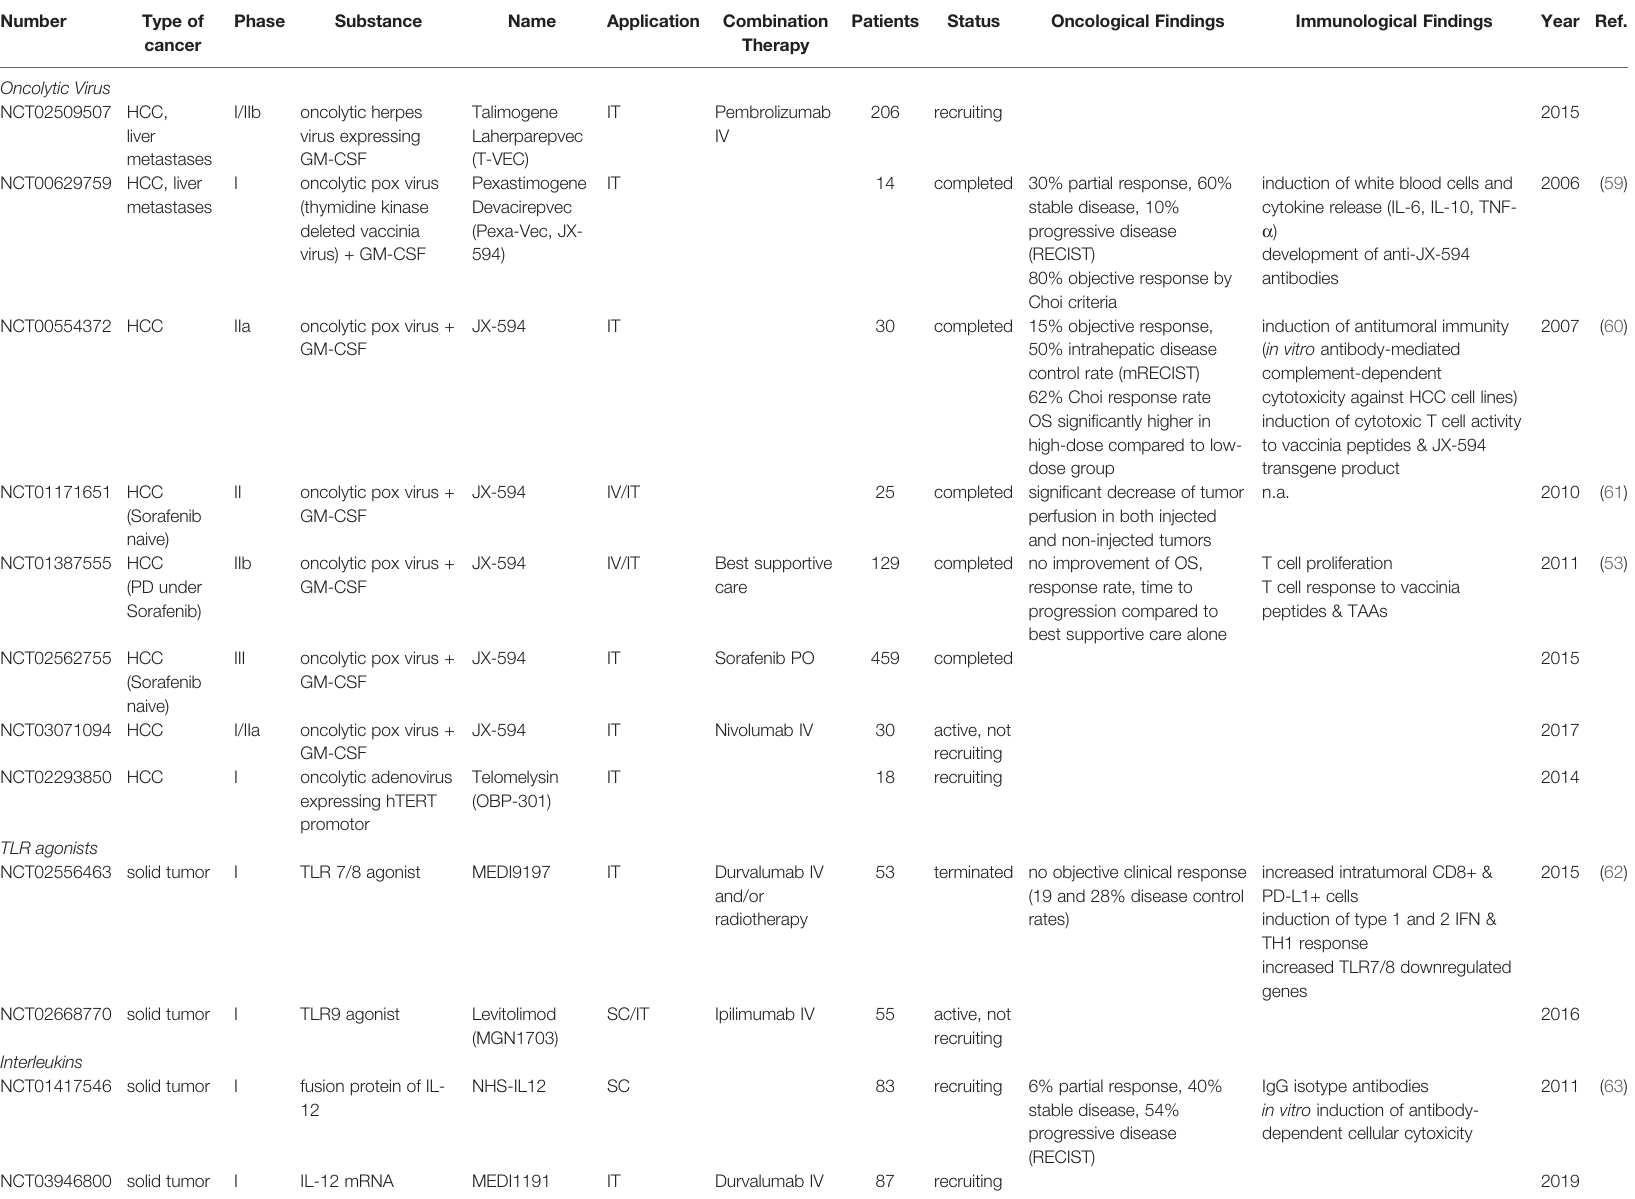
TABLE 1 | Clinical Trials on in situ vaccines in HCC/solid